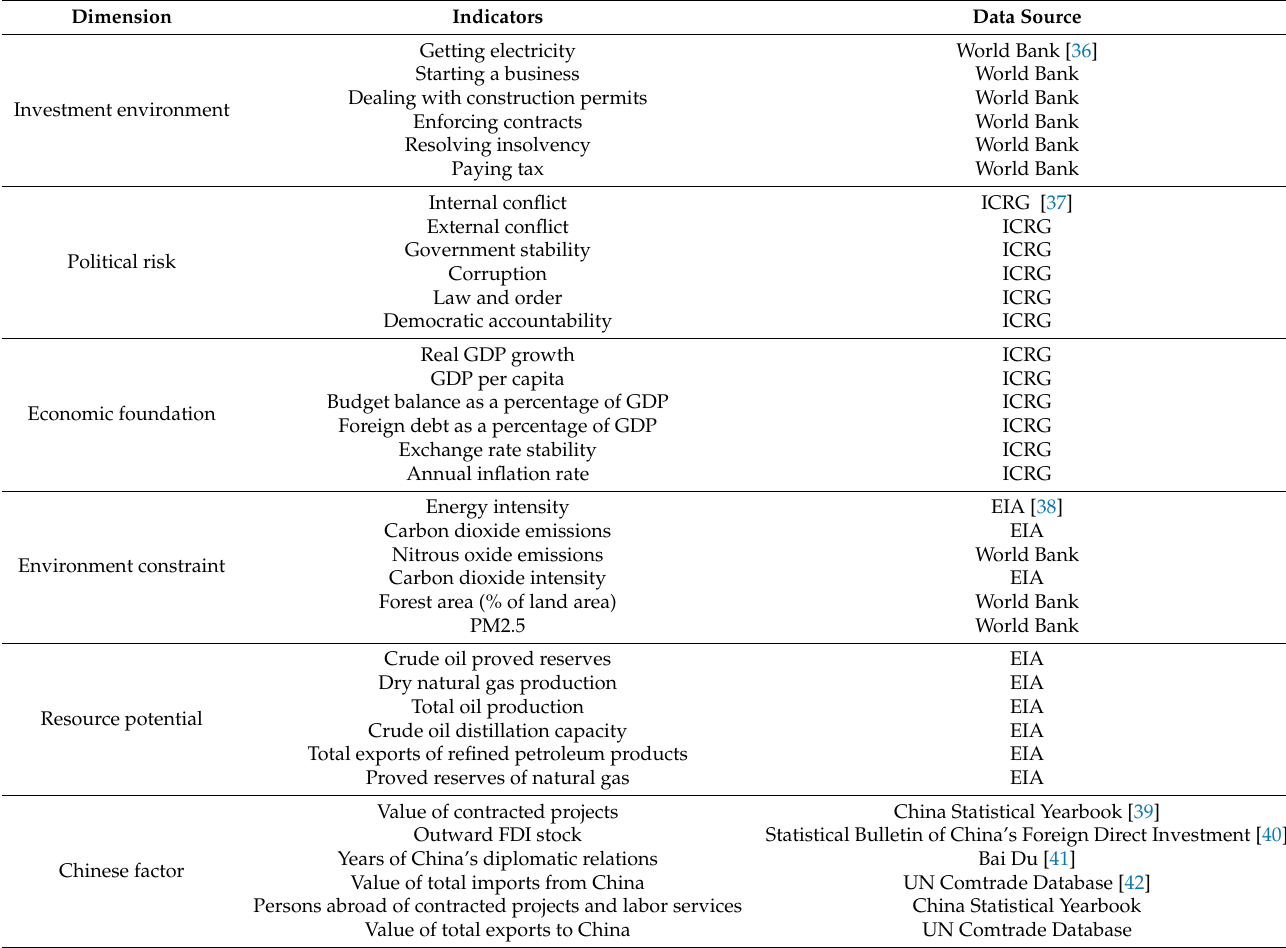
Table 1. Investment risk assessment